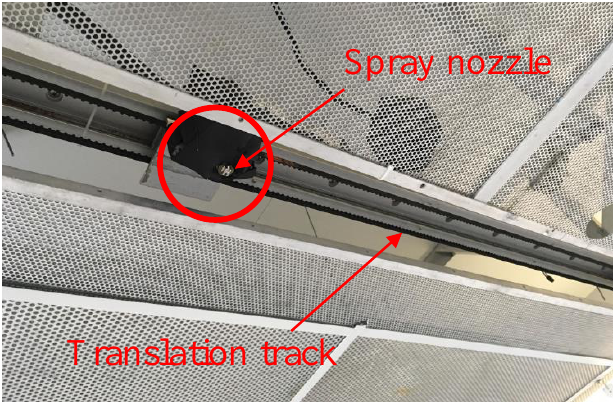
Figure 6. Spray nozzle installed on translation track.